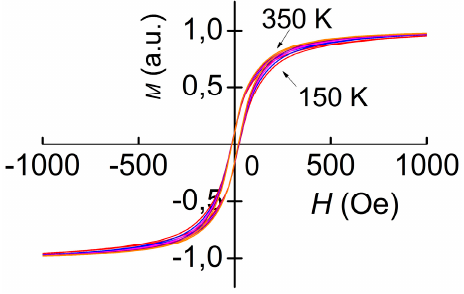
Figure 7. Magnetization curves of the Ni layer for different temperatures T .